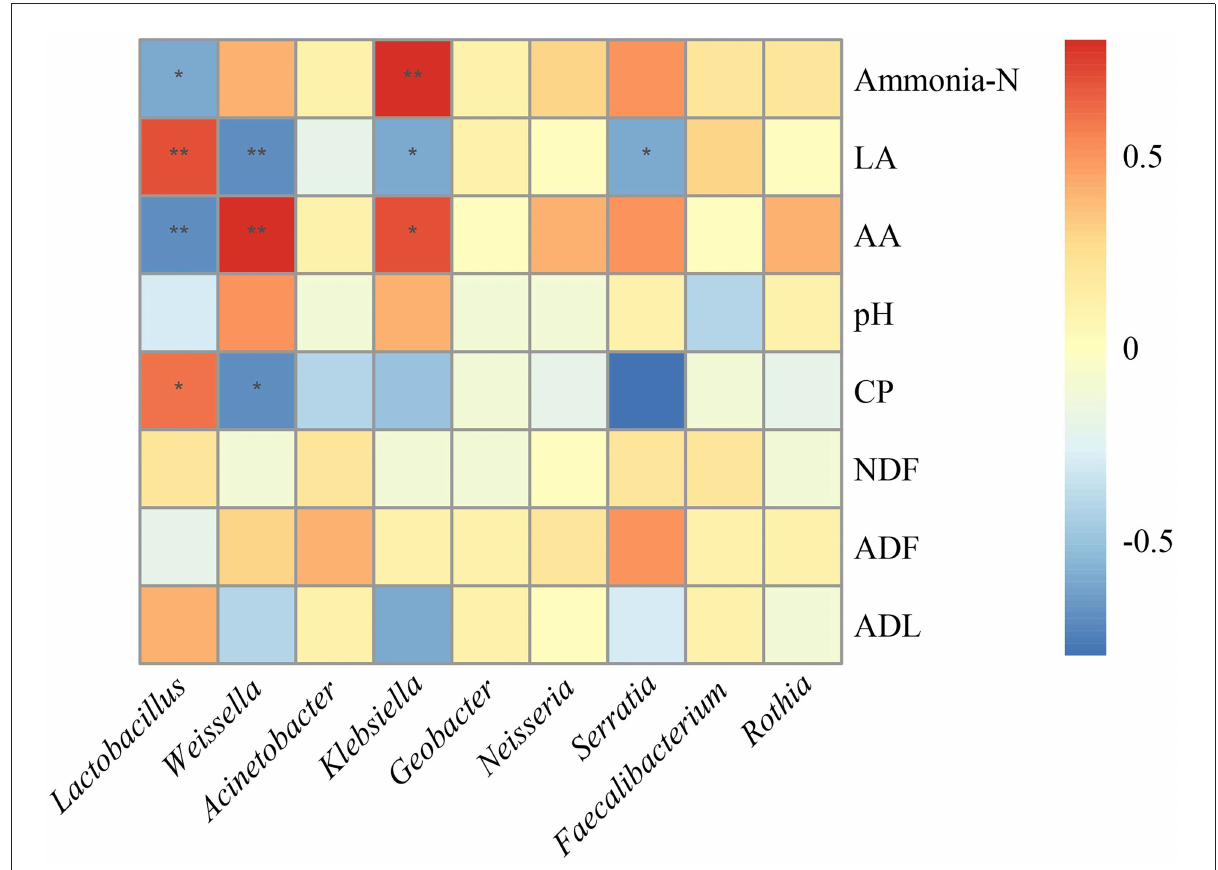
FIGURE4 Correlation analysis between bacterial community and fermentation products after fermentation. LA, lactic acid; AA, acetic acid; CP, crude protein; NDF, neutral detergent fiber; ADF, acid detergent fiber; ADL, acid detergent lignin.